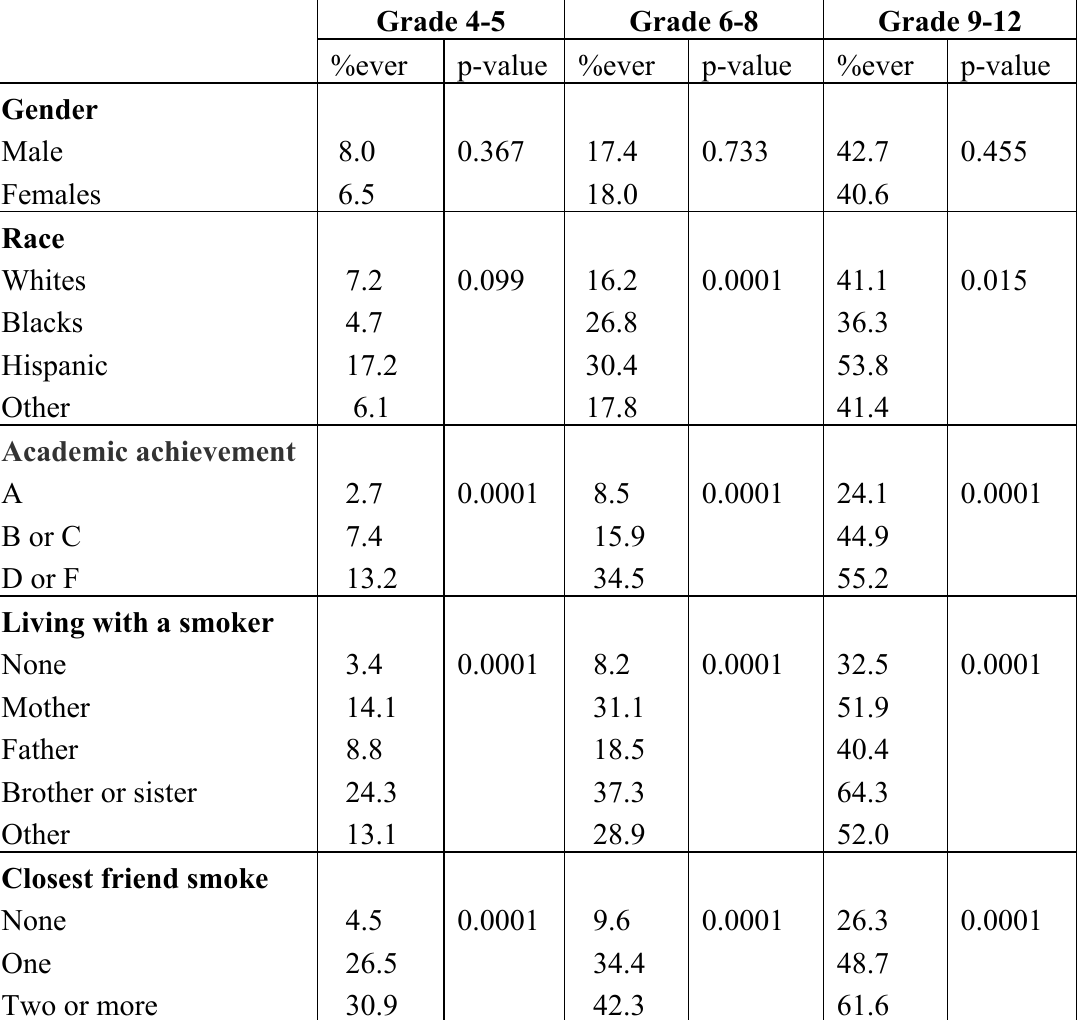
Table 2. The distribution of ever smokers by demographics for different grade